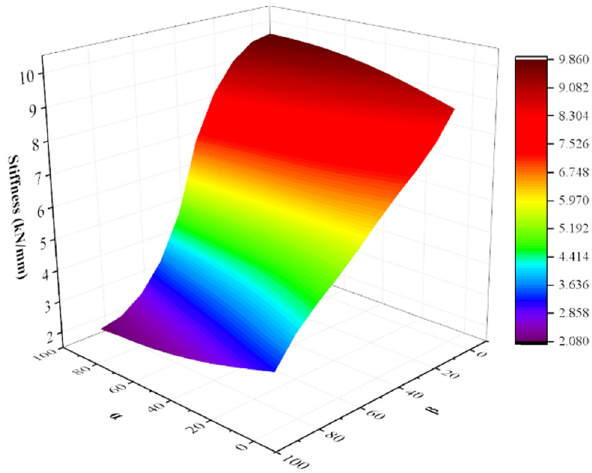
Figure 10: E ff ect of guide angles on the sti ff ness